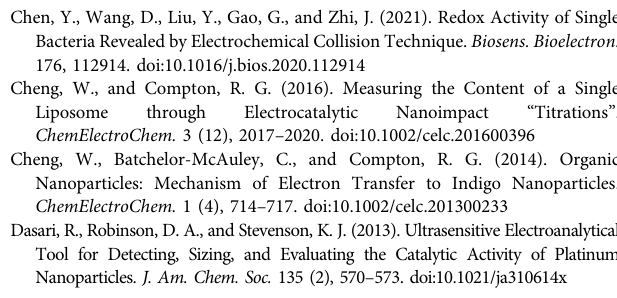
Frontiers in Chemistry |